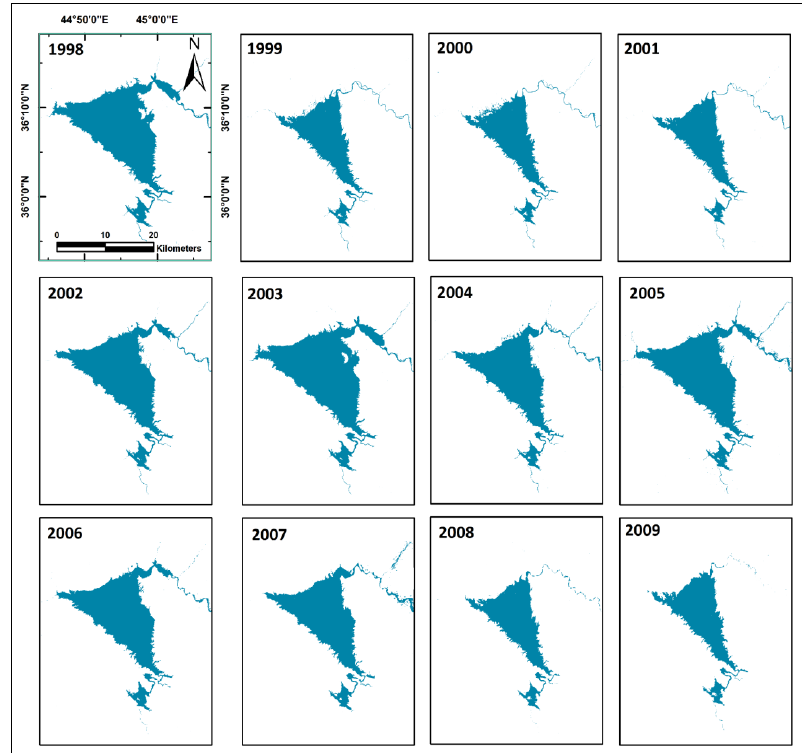
Water 2022 , 14 , x FOR PEER REVIEW Figure 6. Dukan Lake area change from 1998 − 2009. Figure 6. Dukan Lake area change from 1998–2009.